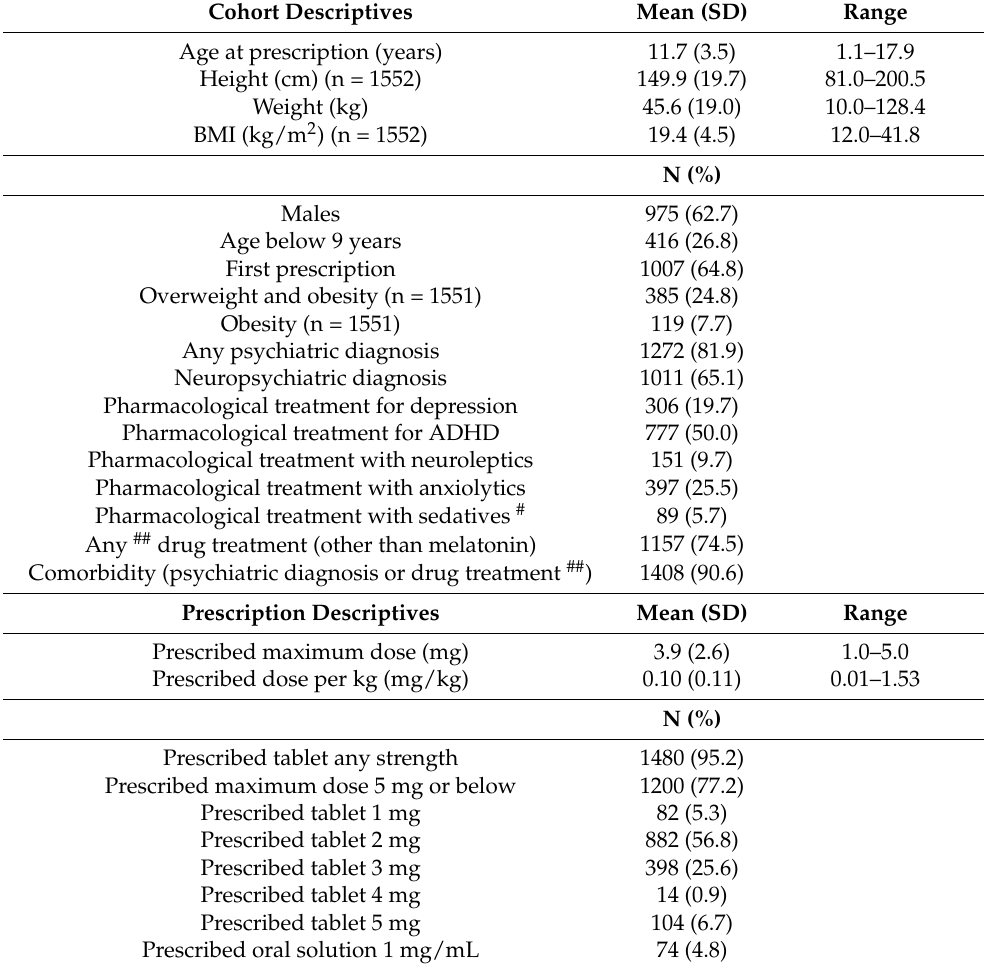
Table 1. Cohort and prescription